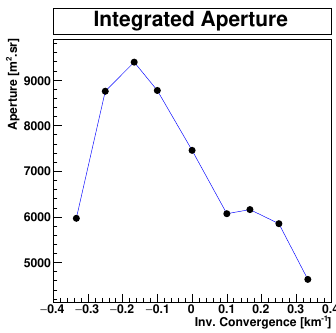
Figure 5. Integrated aperture for the various pointing